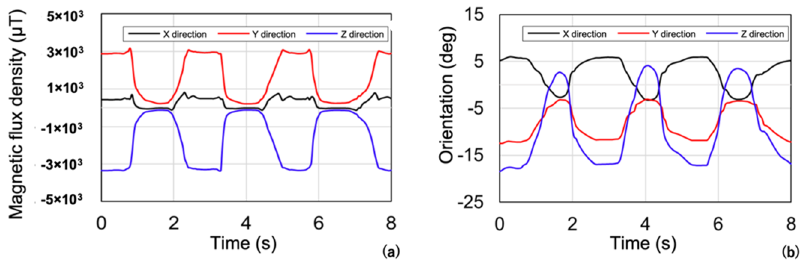
Figure 15. Time development of ( a ) magnetic flux density and ( b ) orientation of the mandibular jaw during the patient’s maximum mouth opening.